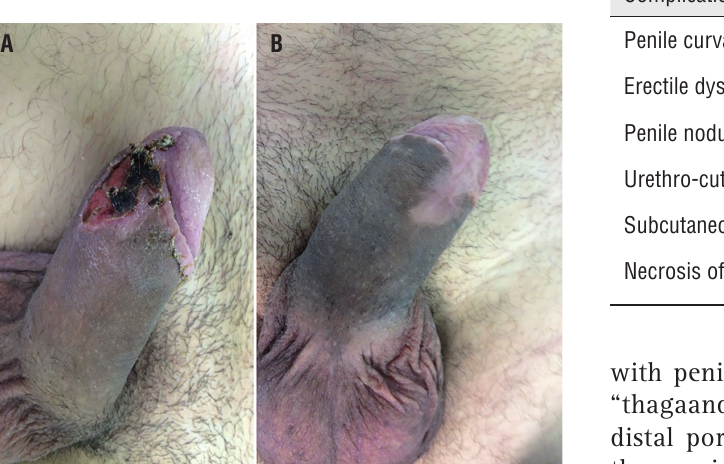
Figure 3 - A-Necrosis of the surgical wound after circumcision B - Satisfactory evolution after conservative treatment with local dressings and with and secondary healing.